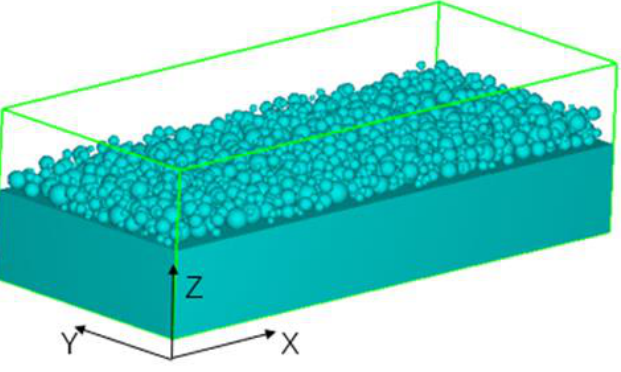
Figure 4. Computational domain.